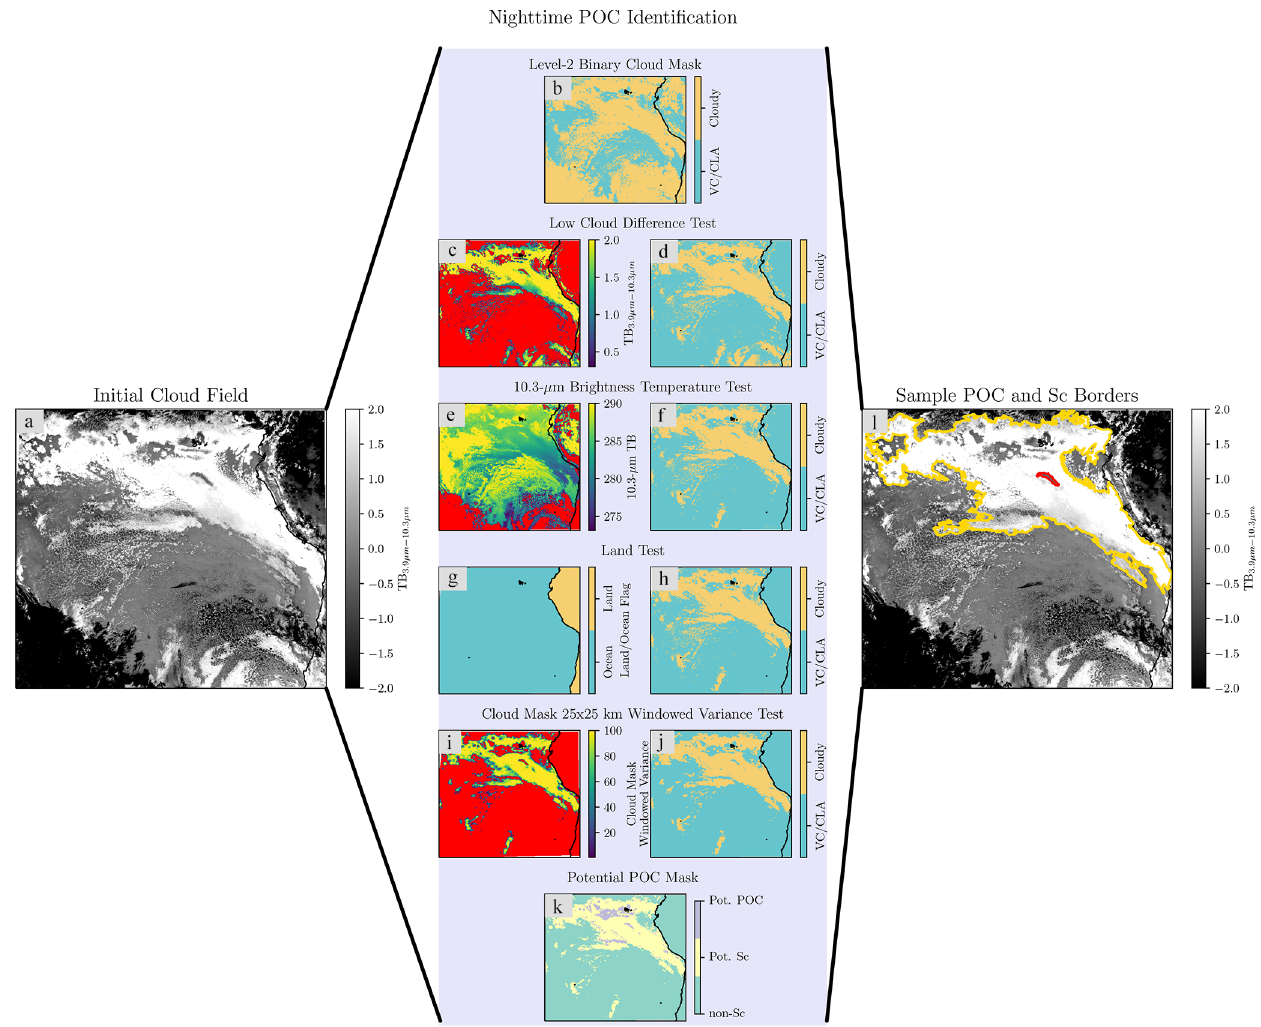
Figure 3. The steps used to identify pockets of open-cell (POCs) stratocumulus during the night. In (l) the stratocumulus deck borders are in yellow and POC borders are in